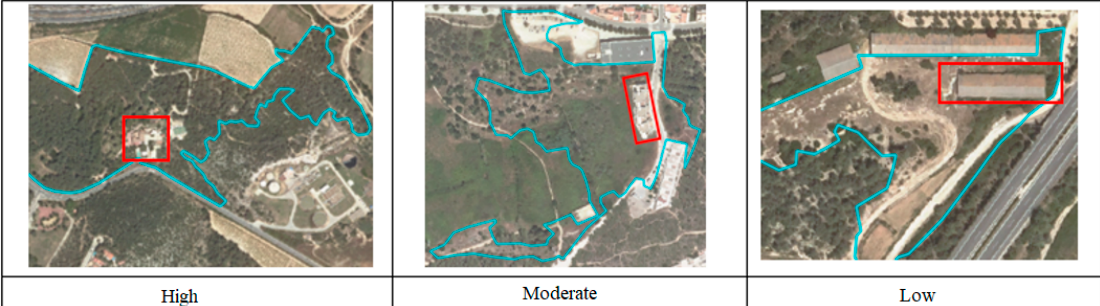
Figure 7. Generalized identification of the level of exposure.